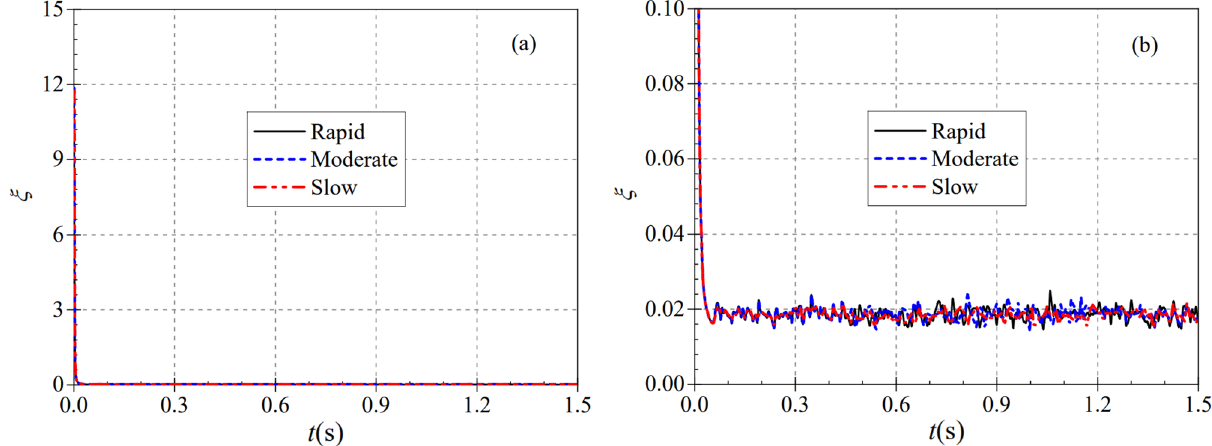
Figure 24. Transient flow resistance coefficients for different start-up conditions. ( a ) Overall diagram, ( b ) Partial